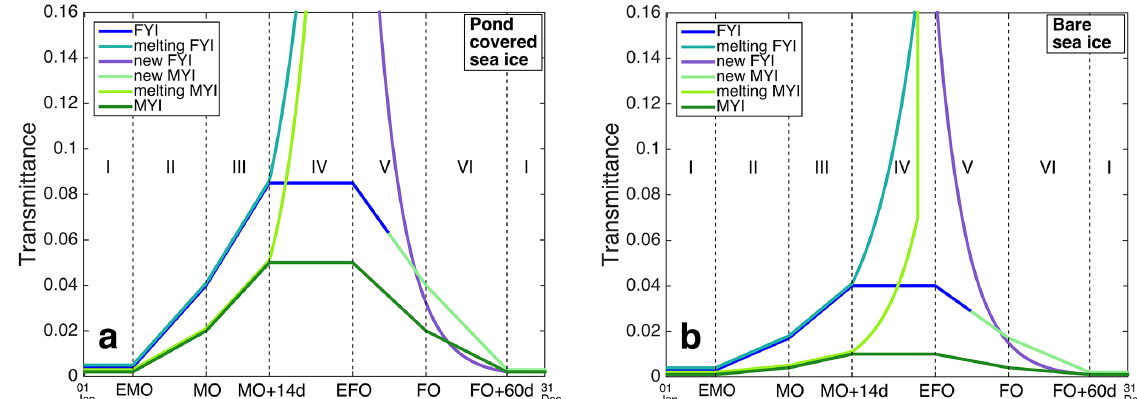
Figure 2. (a) Total transmittance of sea ice during each phase (Fig. 1). In this figure, melt pond concentrations of 26% are assumed for first- year ice (FYI) and 29% are assumed for multi-year ice (MYI). (b) Transmittance of bare ice during each phase (see Fig. 1). Transmittance values for single ice classes are given in Table 1. The illustrated evolution of transmittance values is based on analyses from previous field campaigns and observations. Abbreviations: see Fig.